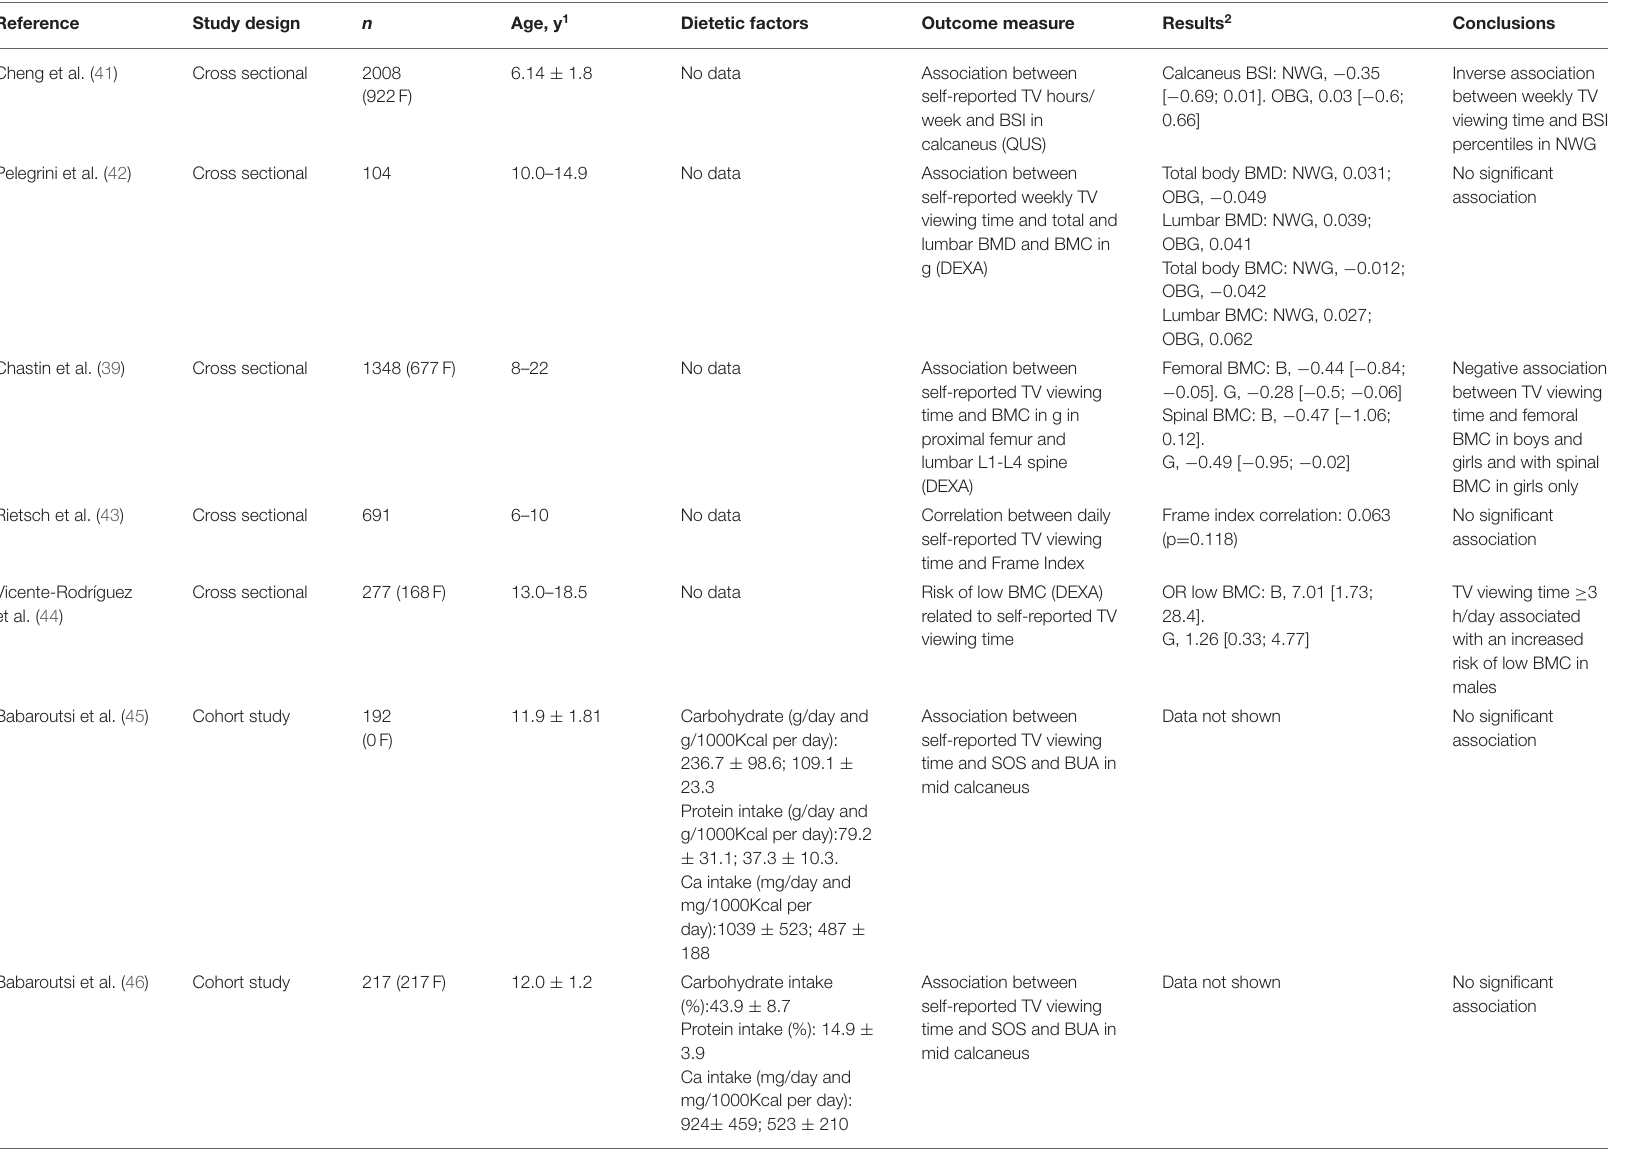
TABLE 2 | Effects of television viewing time on bone